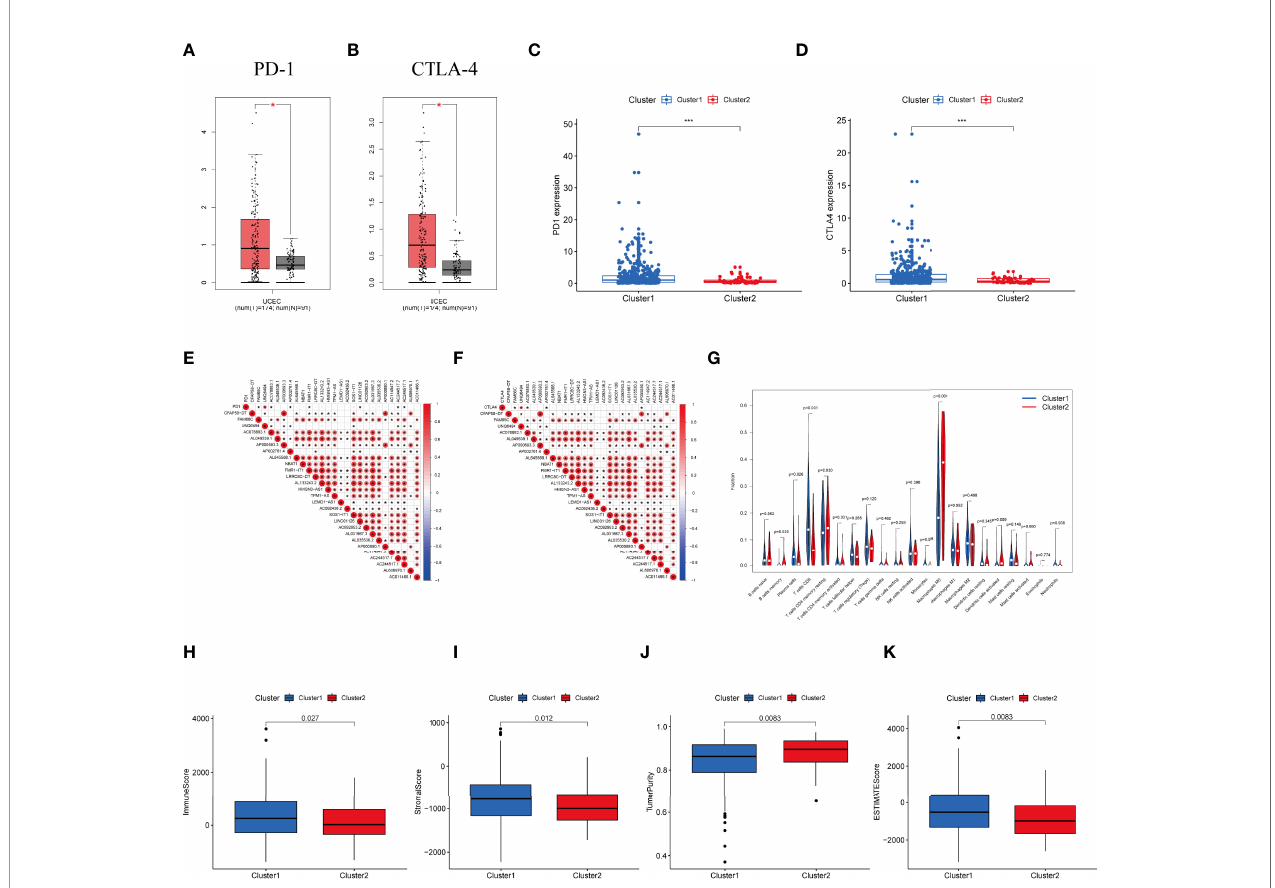
FIGURE 3 | Differential expression pro fi le of immune checkpoint related genes and TME components between clusters. (A) The expression of PD-1 in normal and UCEC tissues. (B) The expression of CTLA-4 in normal and UCEC samples. (C) The expressionion level of PD-1 in the clusters. (D) The expression level of CTLA-4 in the clusters. (E) The correlation of the transcription levels of IRLs and PD-L1, red circle means positive relationship. (F) The correlation of the transcription levels of IRLs and CTLA-4, red circle means positive correlation. (G) The in fi ltrating levels of 21 immune cell types in two clusters. (H – K) The (H) Immunescore, (I) Stromalscore, (J) Tumor purity score, and (K) ESTIMATEscore in cluster 1 and cluster 2. *P < 0.05, ***P <